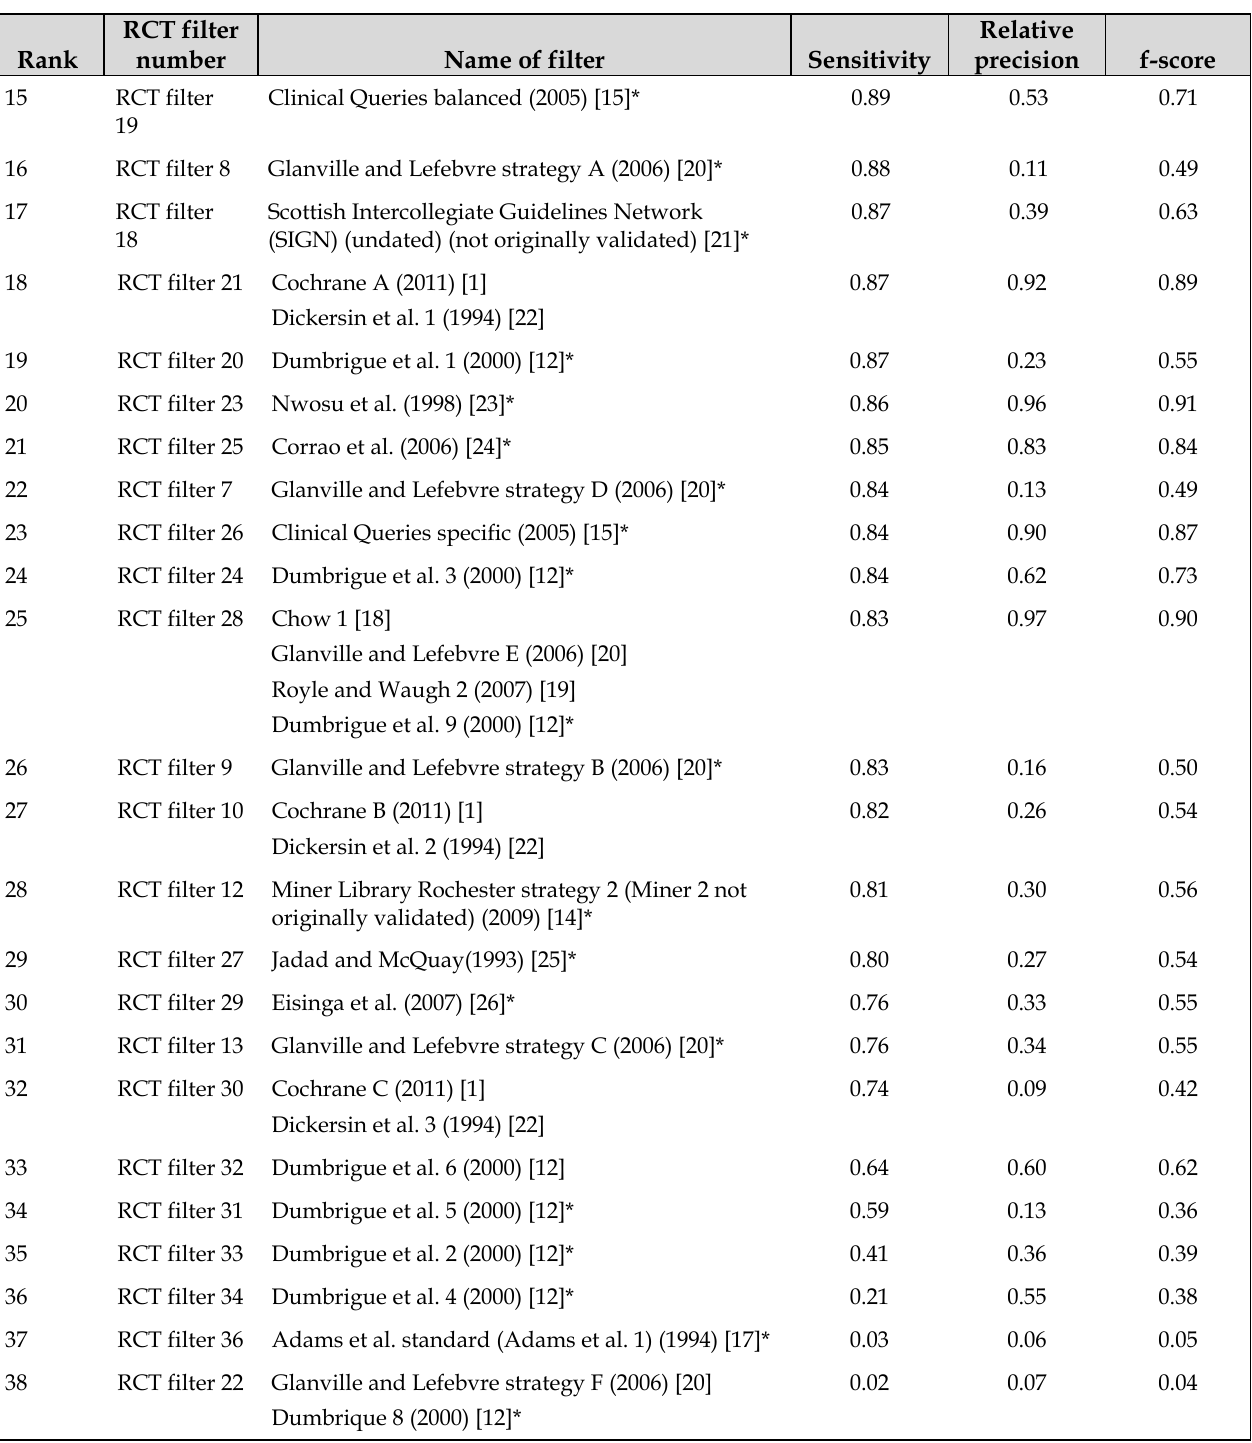
Table 2 Sensitivity, relative precision, and f-score of 38 randomized controlled trials (RCTs) filters (ordered by sensitivity) (continued)